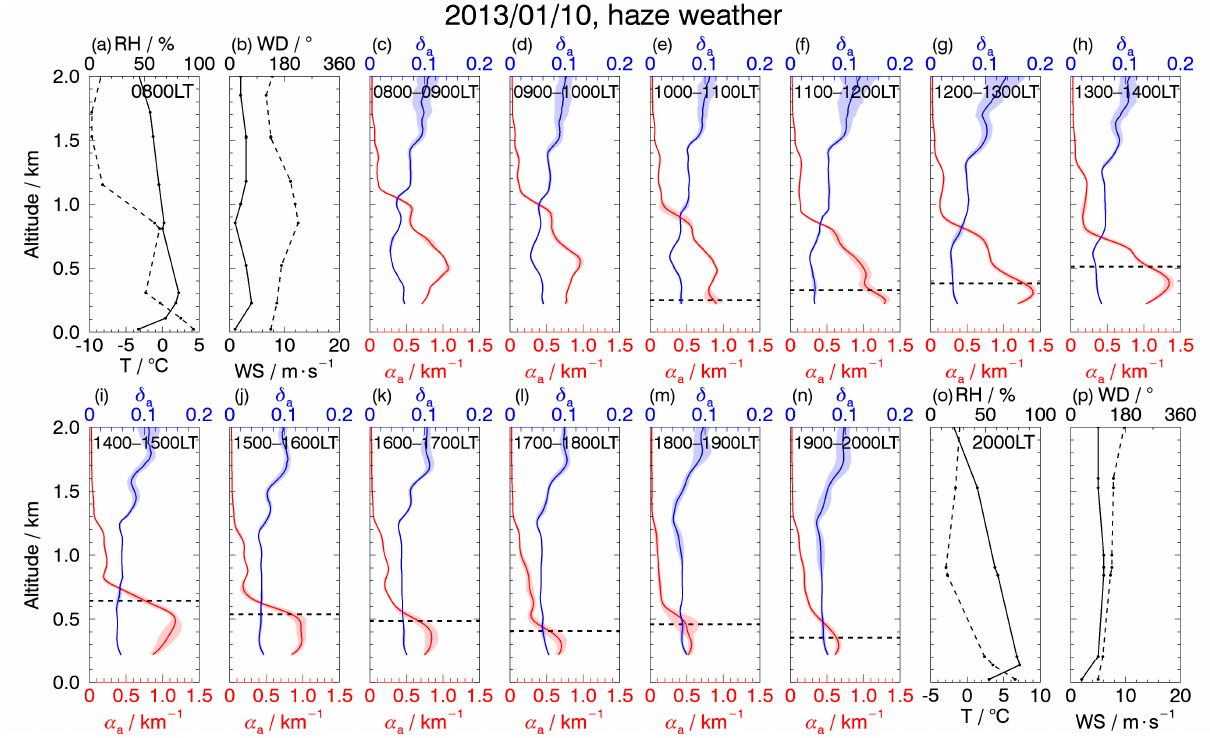
Figure 9. Same as Figure 8 except for 10 January 2013. The weather was hazy, and the evolution of the atmospheric boundary layer (ABL) structure and aerosol vertical distribution was different from that on 31 December 2012.